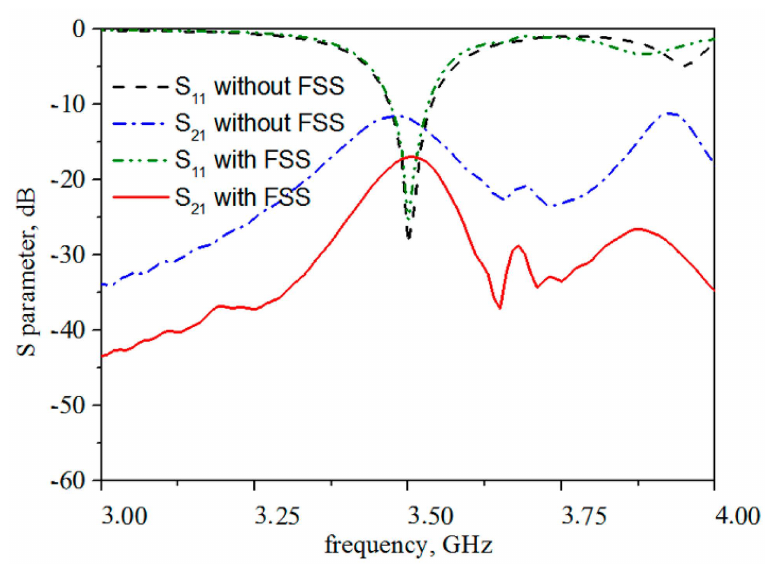
Figure 8. Simulation results of S-parameters for 1 × 2 DRA with and without HCGF FSS wall. In order to control the size of the MIMO antenna, the effect of FSS unit cell number is investigated, as depicted in Figure 9a. The more FSS unit cells there are, the greater the isolation between antenna elements is. When the number of unit cells exceeds 20, the isolation remains virtually unchanged (~18 dB). Considering the isolation and size of the antenna, the proposed FSS consists of 2 × 10 elements, as shown in Figure 9b.